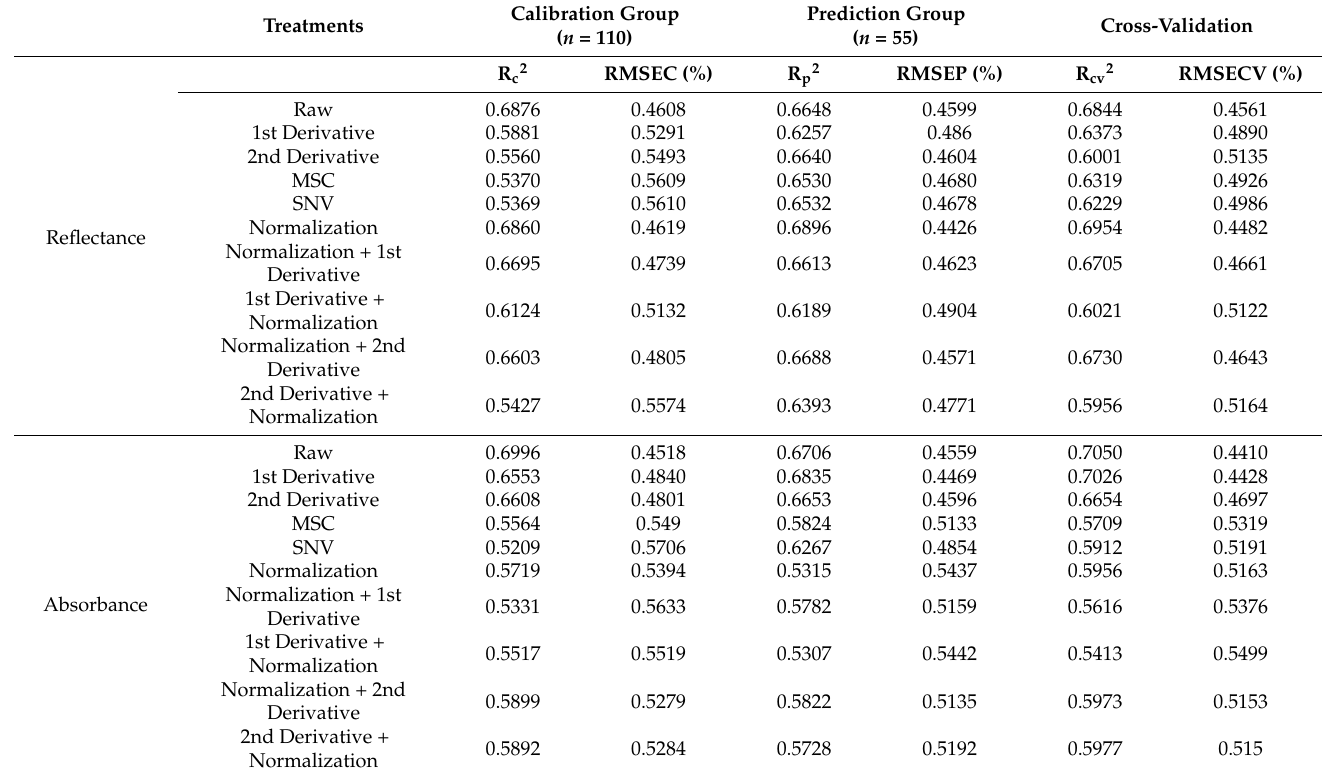
Table 4. Statistical parameters of PLSR with raw and preprocessing spectra based on selected feature